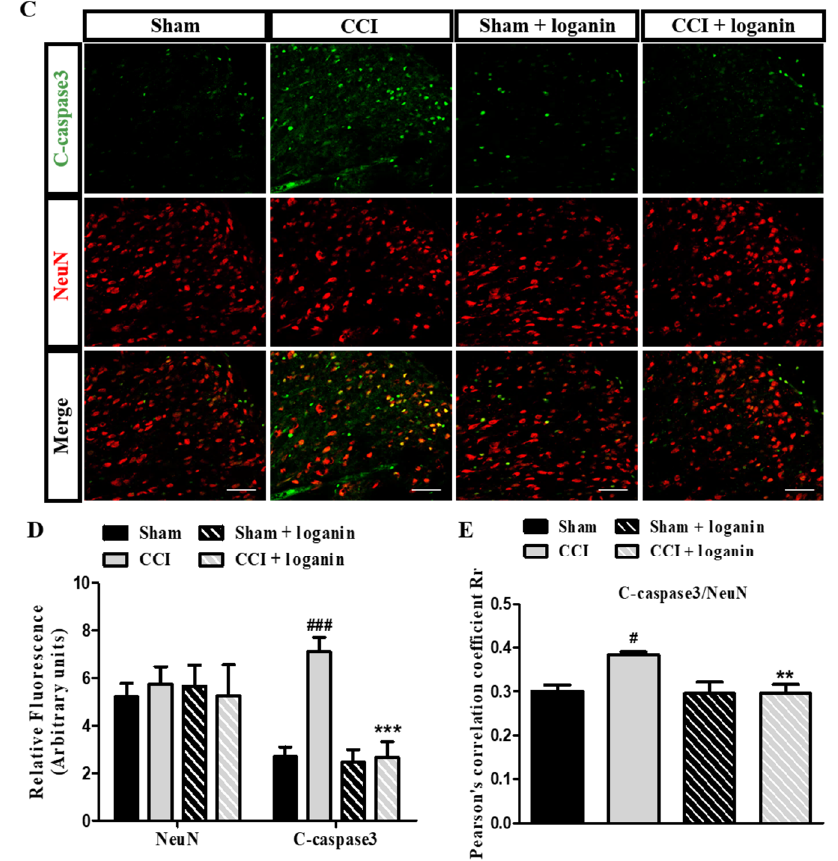
Figure 5. Effects of loganin (5 mg/kg/day, i.p.) on CCI impaired autophagic flux associated with neuronal cell death. ( A ) Representative Western blot analysis of Bax and cleaved caspase3 proteins. ( B ) Quantification of Western data in ( A ). ( C ) Representative images of IHC staining for C-caspase3 (green) and the neuronal marker NeuN (red) in the spinal cord. The scale bar is 50 µ m. ( D ) Quantifi- cation of NeuN and C-caspase3 signals in ( C ). ( E ) Pearson’s correlation coefficients quantified the degree of colocalization between C-caspase3 and NeuN. Sham-operated rats were the subjects of the same procedure without nerve manipulation. These data represent the mean ± SE for 6 rats per group. # p < 0.05, ## p < 0.01, ### p < 0.001 compared with the sham group at the corresponding time points; * p < 0.05, ** p < 0.01, *** p < 0.001 compared with the CCI group.